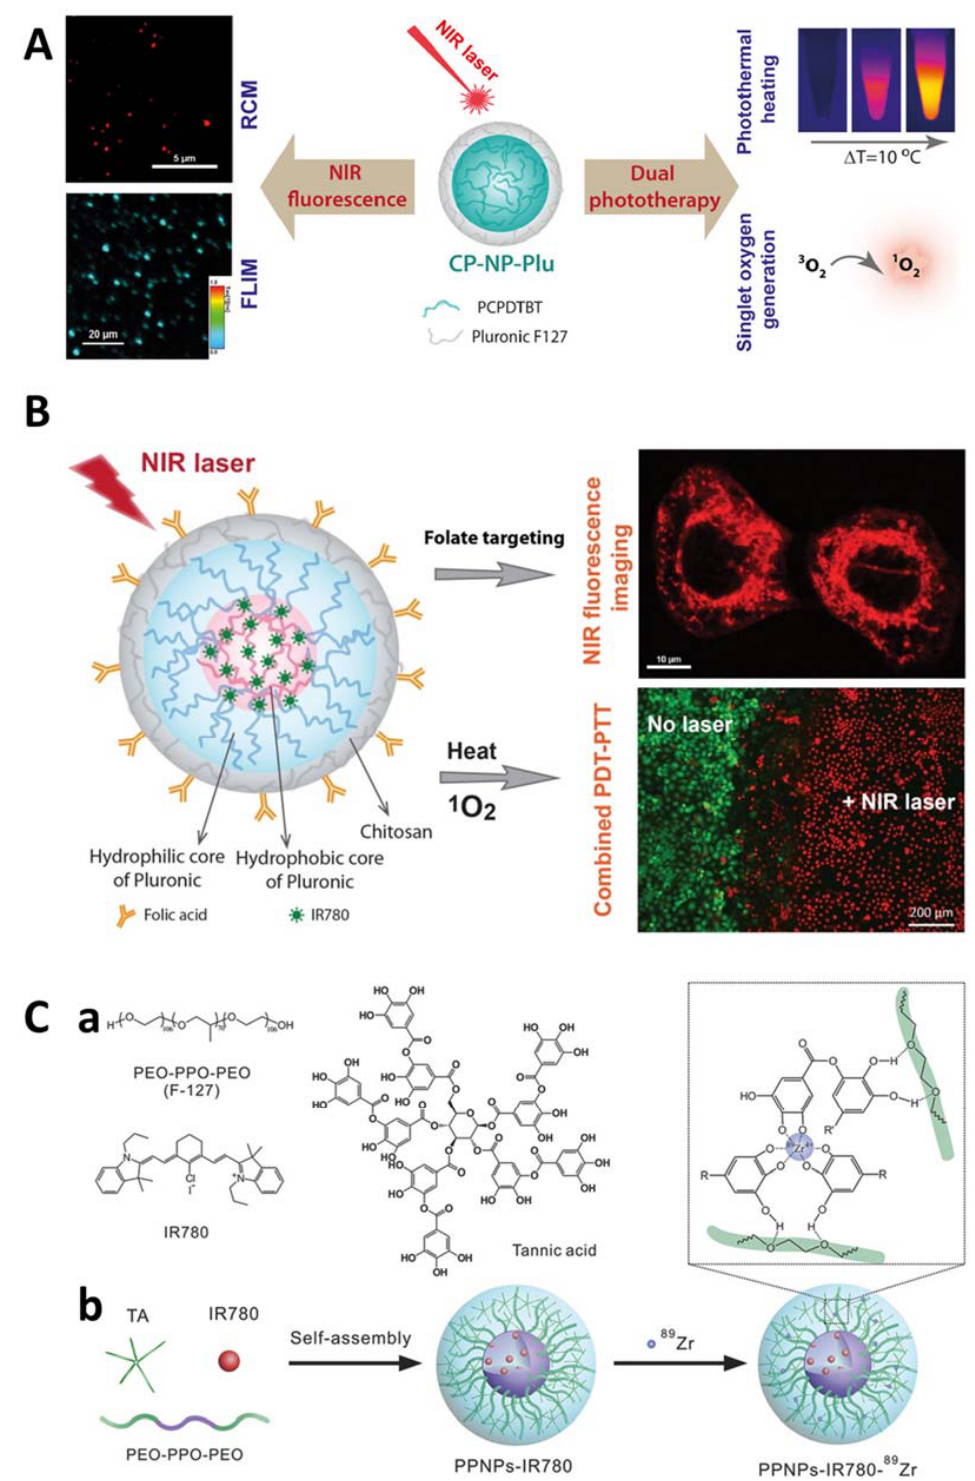
Figure 7. Examples of Pluronic ® ‐ based approaches for nanotheranostics. In ( A ), it schematically represents the development of Pluronic ® F127 stabilized conjugated polymer nanoparticles for Near Infra ‐ Red (NIR) fluorescence imaging and dual phototherapy applications. Reprinted from [130] Copyright 2021, with permission from Elsevier. In ( B ), is a representative scheme of the formulation of folate ‐ targeted Pluronic ® F127 ‐ chitosan nanocapsules that are loaded with Infra ‐ Red (IR)780 for near ‐ infrared fluorescence imaging and photothermal ‐ photodynamic therapy of ovarian cancer. Reprinted from [131] Copyright 2021, with permission from Elsevier. In ( C ), it represents a schematic